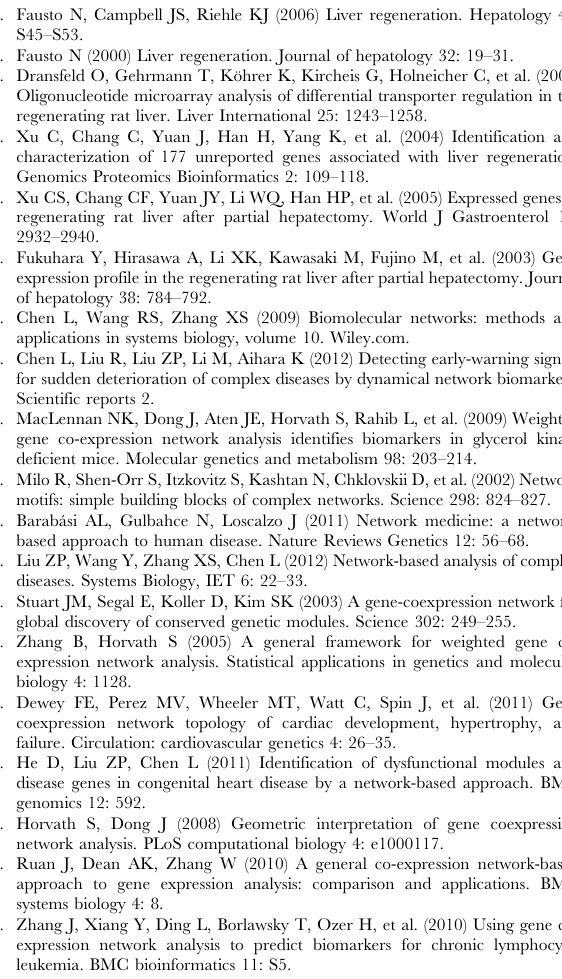
Table S2 Detailed functional enrichment of GO anno- tations in LR-related modules. (XLSX) Table S3 Detailed pathways enriched in LR-related modules. Table S4 The gene interactions in the salmon